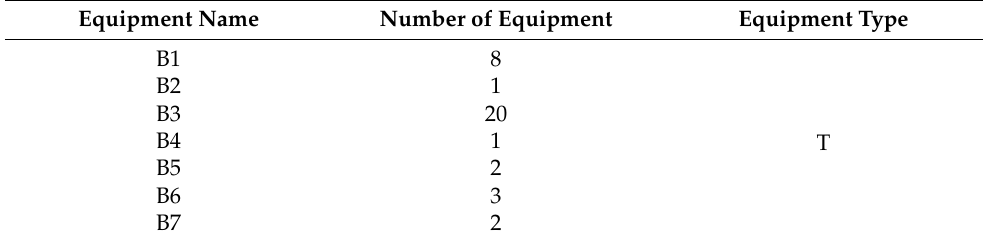
Table 3. Basic attributes of the blue side’s equipment.